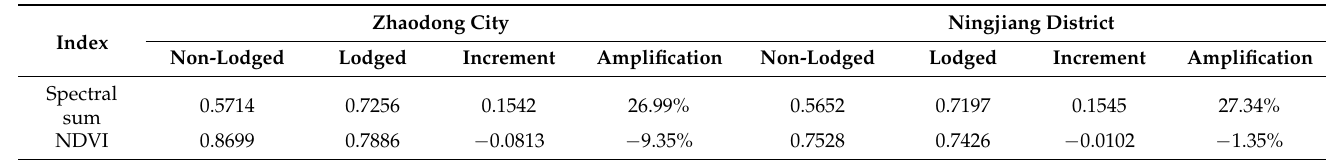
Figure 8. The values of the normalized difference vegetation index for the lodged and non-lodged maize in ( a ) Zhaodong City and ( b ) Ningjiang District. Table 5. The change in the normalized difference vegetation index and spectral sum index between the lodged and non-lodged